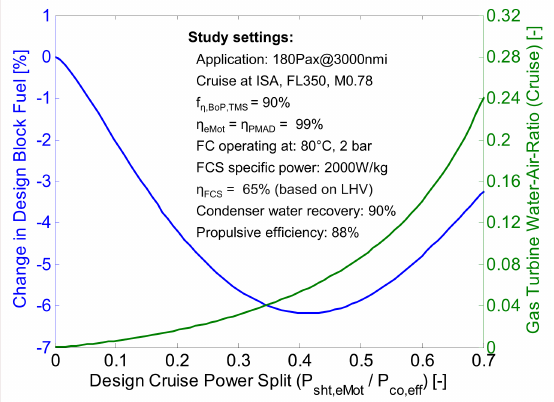
Figure 11. Design block fuel and GT water-to-air ratio trends for selected aircraft design study